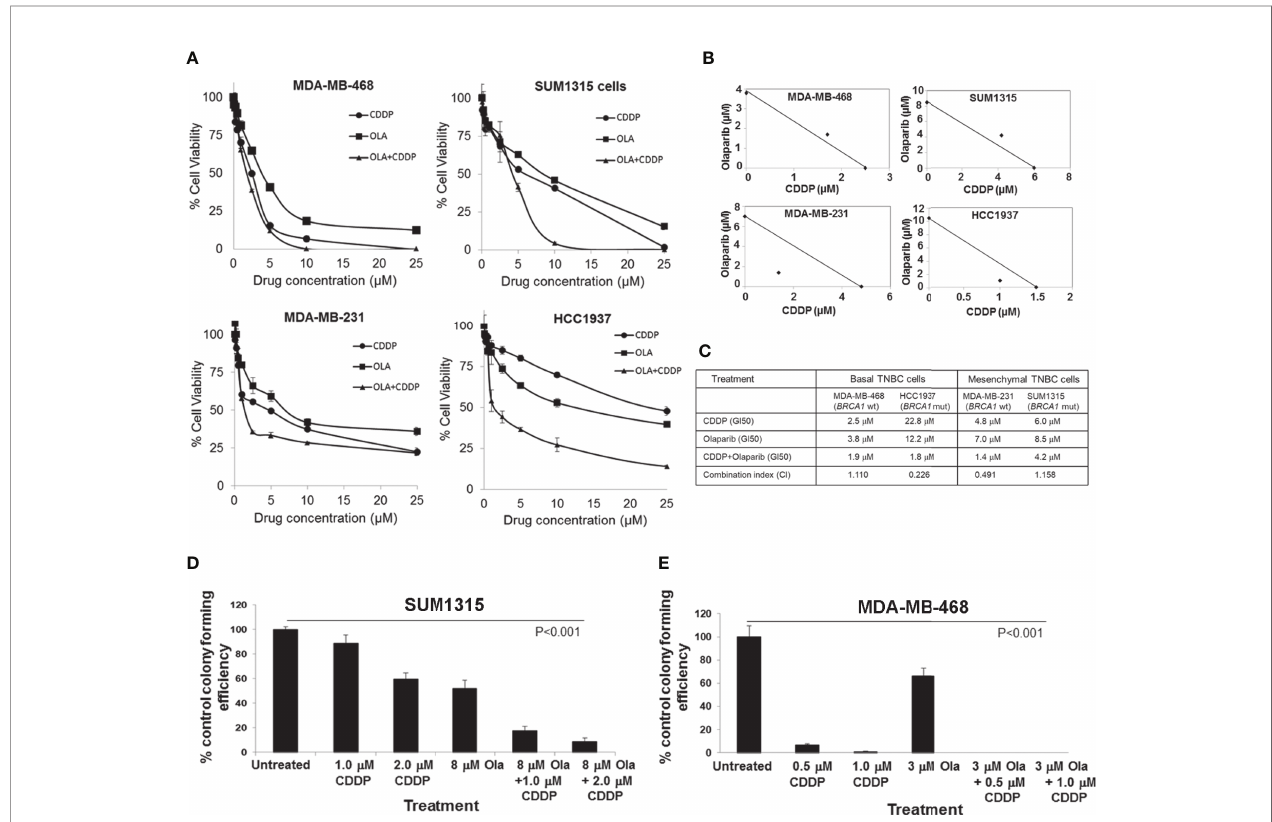
FIGURE 1 | Olaparib and cisplatin (CDDP) in vitro sensitivities are not in fl uenced by the BRCA1 status of TNBC cells. (A) MTT assays of MDA-MB-468, SUM1315, MDA-MB-231 and HCC1937 cells. Data are mean ± S.D. of three independent experiments. (B) Isobologram analysis of the combination of olaparib and CDDP in constant 1:1 ratio. The individual doses of olaparib and CDDP to achieve 50% growth inhibition (GI50) are plotted on the axes, and the position of the observed dose pair is indicated. Points falling below the line indicate synergism whereas those above the line indicate antagonism. (C) GI50 values for olaparib, CDDP, their combination (constant 1:1 ratio), and combination index (CI) values calculated using CompuSyn. (D, E) Clonogenic analysis of olaparib, CDDP and their combination at the indicated doses in SUM1315 (D) and MDA-MB-468 (E) cells. Results are expressed as mean ± S.D. (percent of control colony formation ef fi ciency) from three independent experiments and analyzed by one-way ANOVA, P<0.001. Pairwise post-hoc analysis using Holm ’ s procedure was performed to compare effects caused by combination treatments to those caused by single treatment ( Supplementary Tables 1 and 2